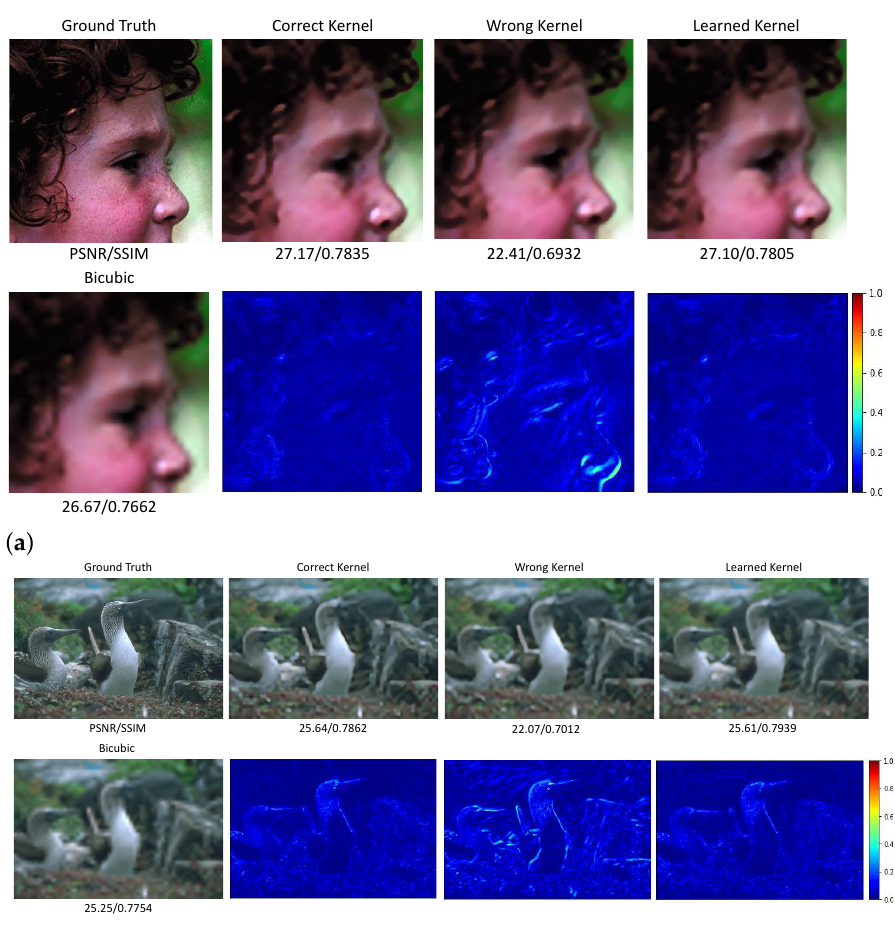
Figure 2. The experimental results of two images from the Bicubic down-sampled LR observation with the upscale factor 8. The first row gives the recovered HR images with different kernels, and the second row visualizes the difference in image between the ground truth and their corresponding estimations. ( a ) The ’head’ image in Set5. ( b ) The ’103070’ image in